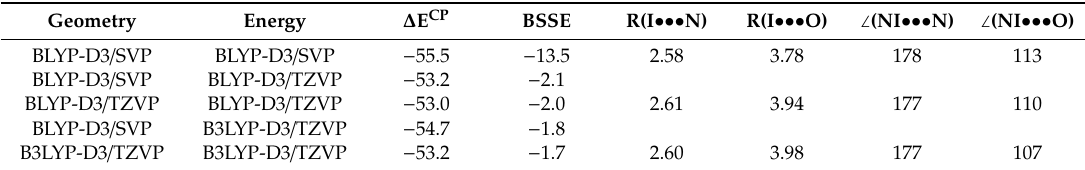
Table 1. Interaction energies and BSSE (basis set superposition error) values (in kJ / mol) and selected geometrical parameters (distances in Å; angles in degrees) of the I1,I2-substituted R-I dimer, calculated at di ff erent levels of